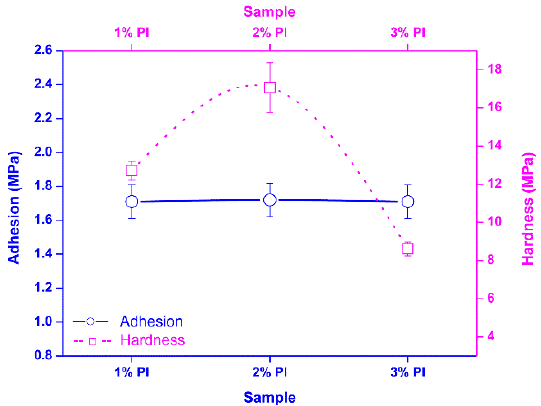
Figure 3. Adhesion and hardness of high refractive index (HRI) coatings with different PI concentrations.